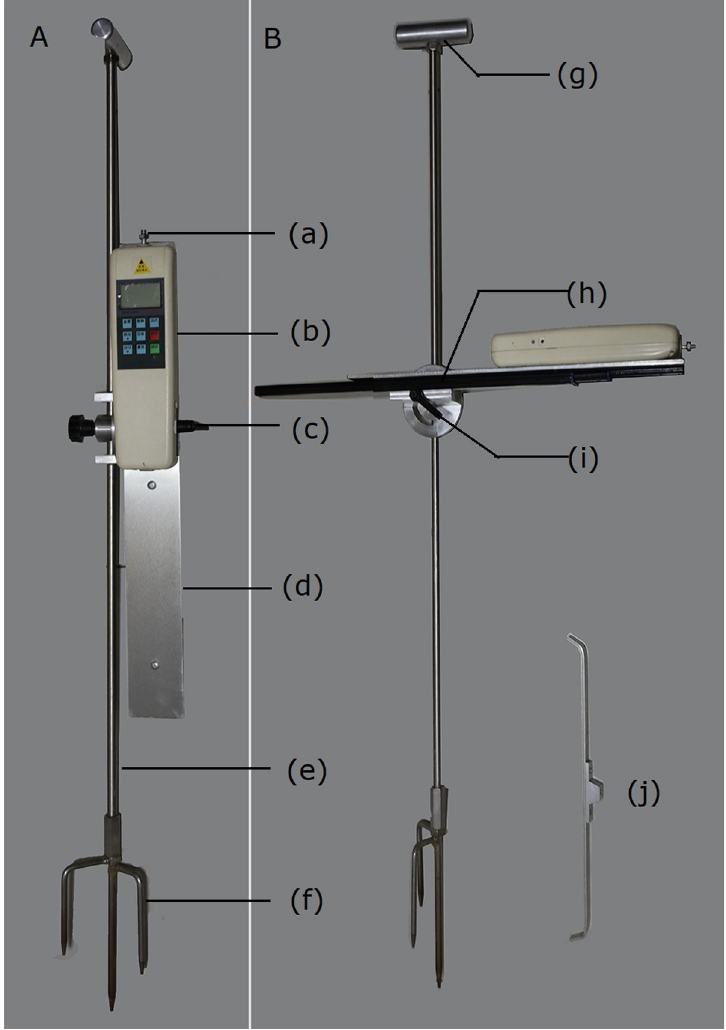
Fig 2. The rapid measuring instrument for crop lodging resistance. A. Instrument folding state. B. Instrument unfolding state (working state). Composition and name: (a) probe mounting position; (b) dynamometer; (c) connecting plate locking handle; (d) dust-proof connecting plate; (e) circular ruler rod; (f) three tooth steel fork; (g) circular ruler rod handle; (h) ball guide way; (i) rotary positioning plate; (J) population lodging thrust force probe.